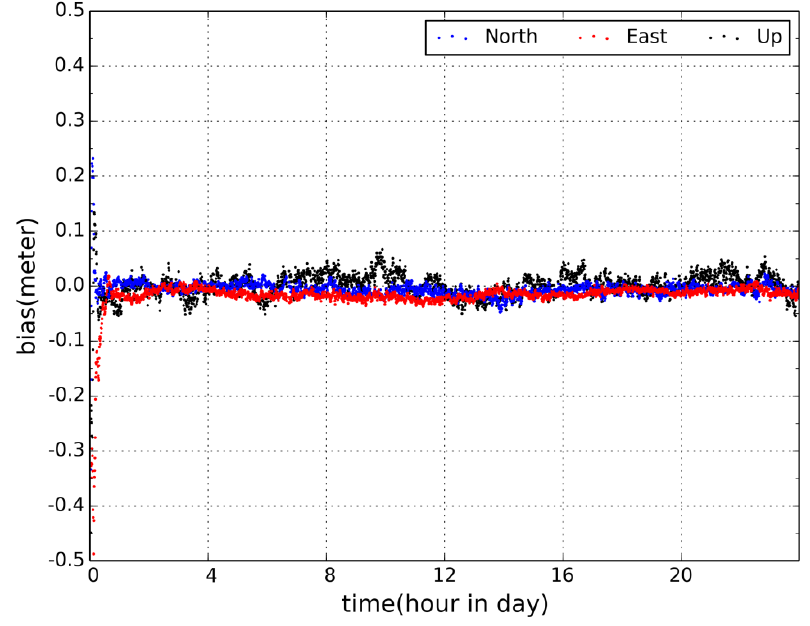
Figure 11. Result of real-time precise point positioning (PPP) using decentralized clock estimation (DECE) clock (ASCG).